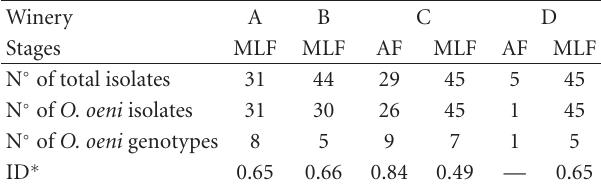
Table 3: Number of isolates and genotypes of O. oeni and index of diversity (ID ∗ ) during AF and MLF.